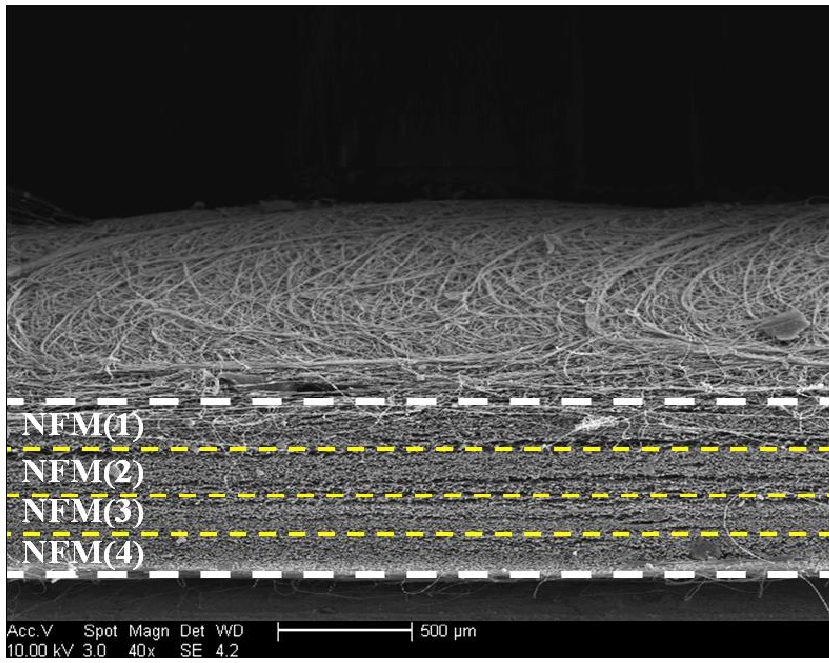
Figure 2. Scanning electron microscope (SEM) image for cross-section of membrane unit assembled by unremittingly spinning NFM( i ) ( i = 1, 2, 3, 4) nanofibrous membranes together.